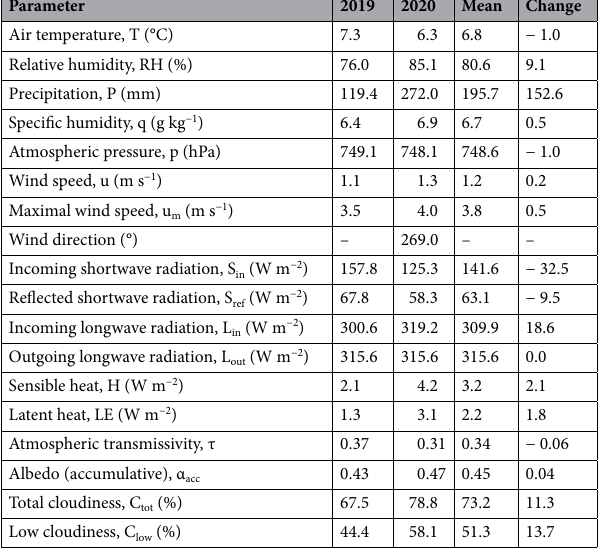
Table 1. Mean values of meteorological and radiation parameters on the glacier for the period 7 July to 23 August. Cloudiness data were obtained at the Chara weather